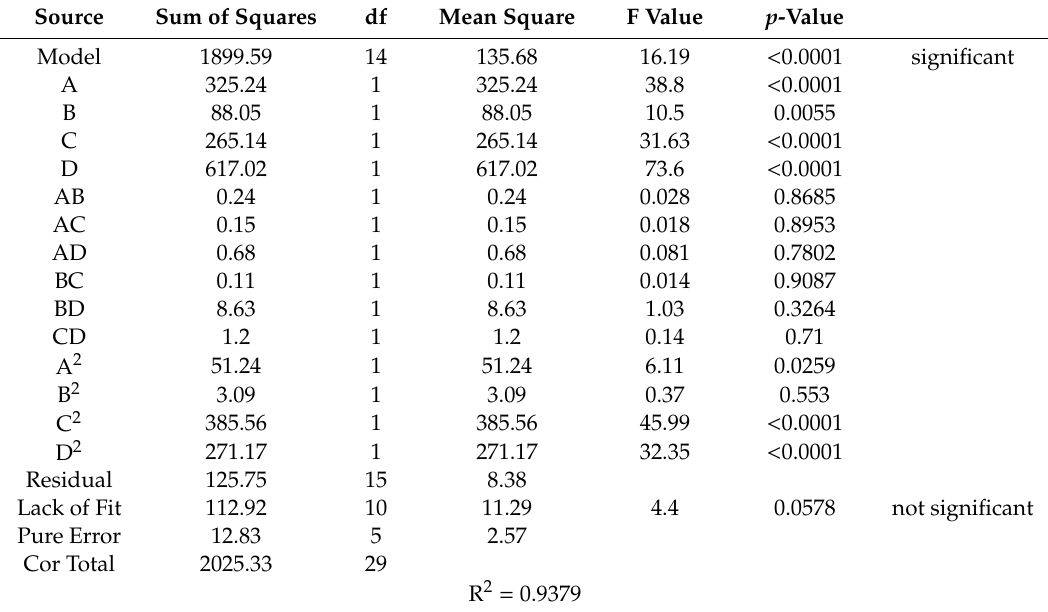
Table 3. Results of ANOVA for response surface quadratic